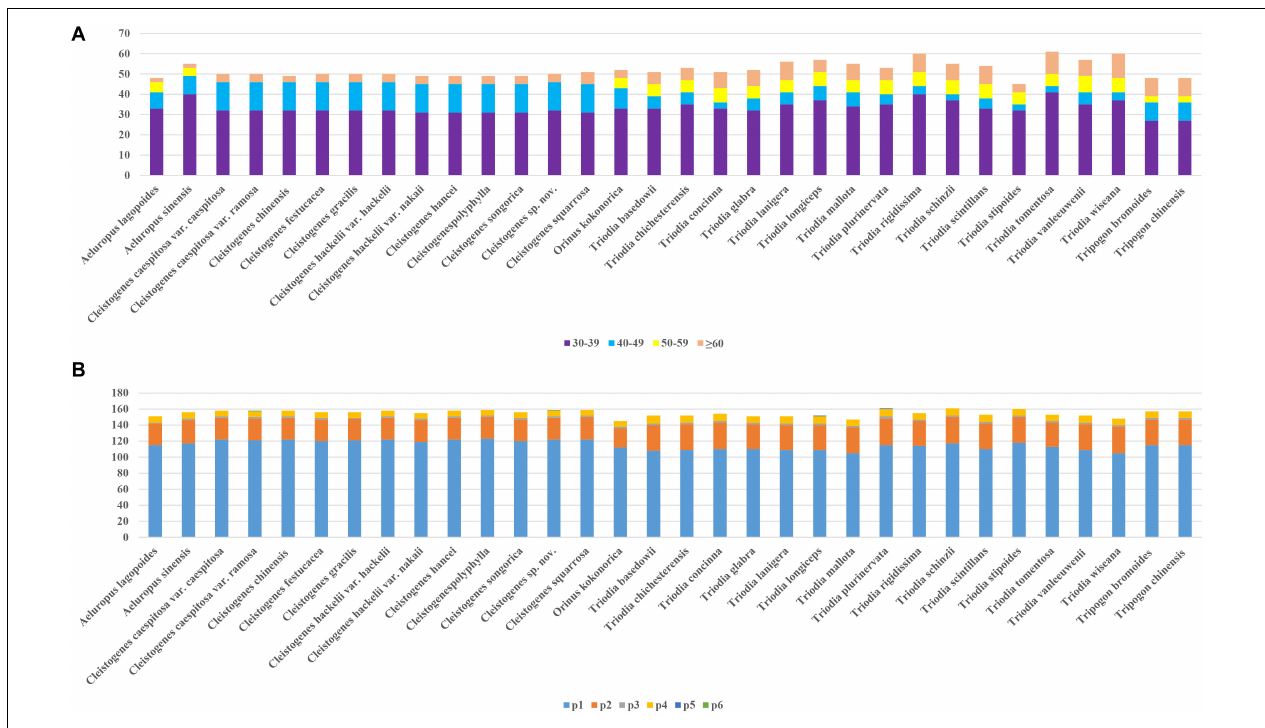
FIGURE 2 | Repeats in 32 plastomes. (A) The number of repetitive sequences by lengths; (B) The number of different types of SSRs (p1–p6 indicate mono-, di-, tri-, tetra-, penta-, hexanucleotides,